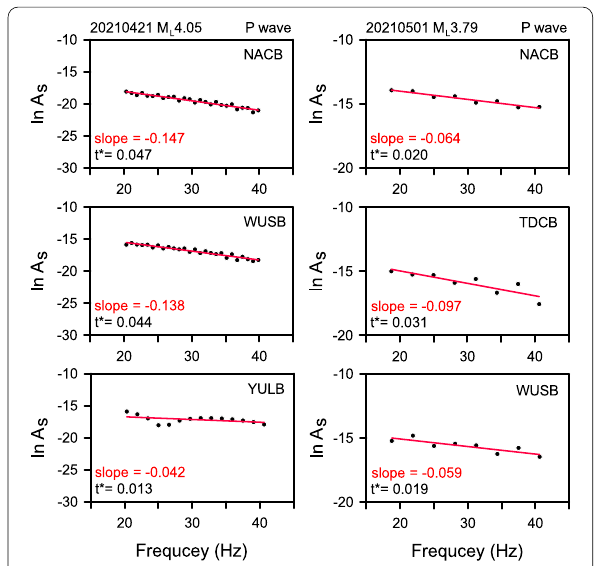
Fig. 7 Calculation of t* for P‑waves by using acceleration recordings. Two examples of the t* estimations from two aftershocks, 20100421 M L 4.05 and 20210501 M L 3.79 events, are